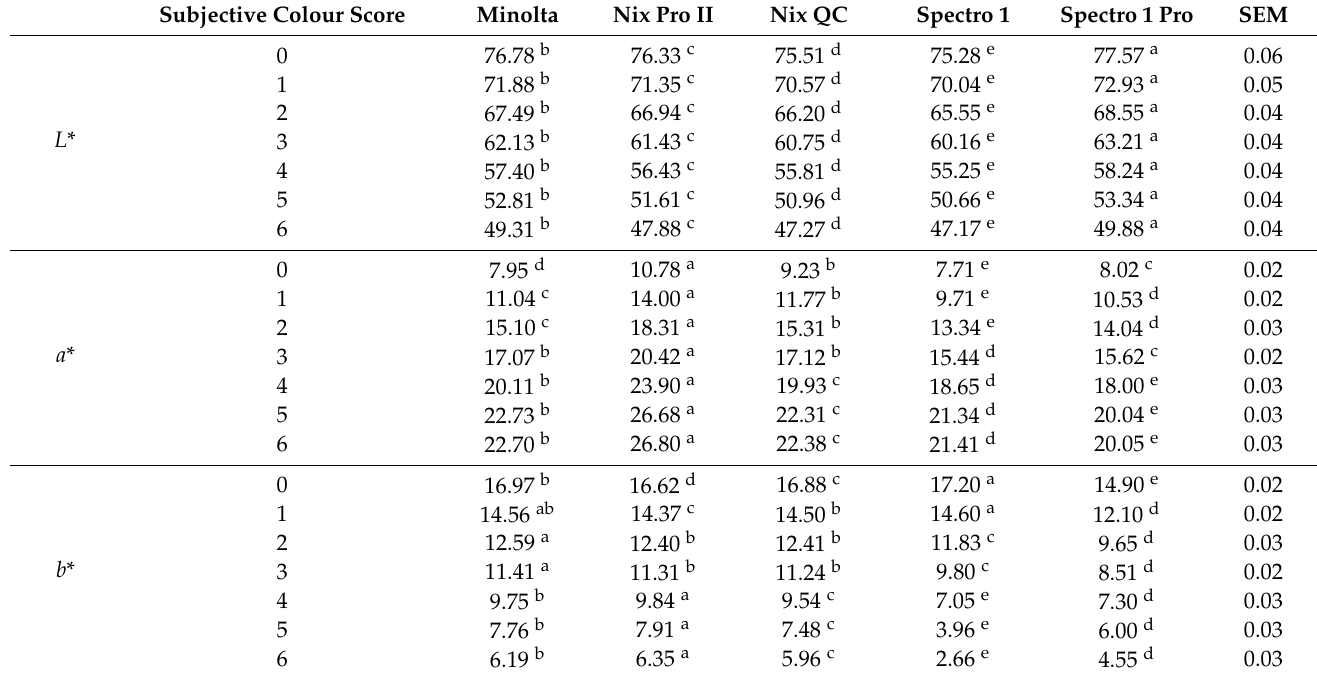
Table 1. Instrument effect on mean CIE ( L *, a *, and b *) values of Canadian colour